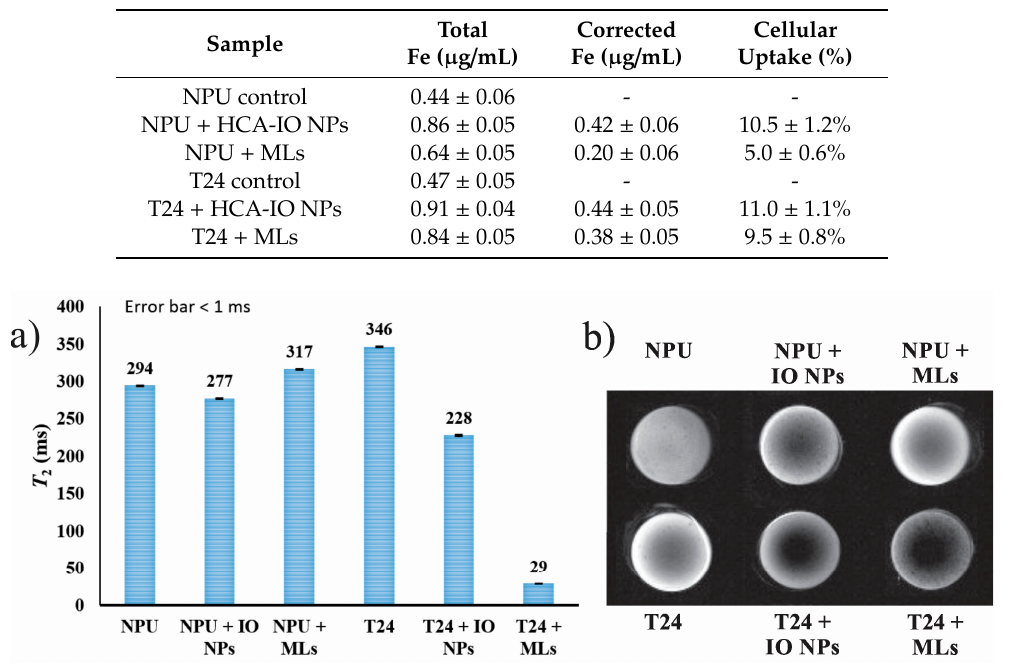
Figure 3. Magnetic resonance imaging (MRI) measurements of MLs in NPU and T24 cells. ( a ) T 2 relaxation times and ( b ) T 2 -weighted image taken from cell pellets following 24 h of incubation with HCA-IO NPs or MLs (DOPC / Chol formulation). Untreated cells were used as controls. Imaging parameters were TE / TR = 13 / 2000 ms (inter-echo time / repetition